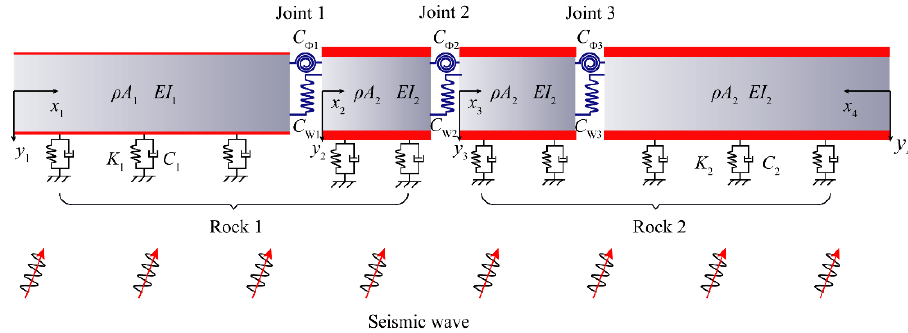
Figure 2. Analytical model.